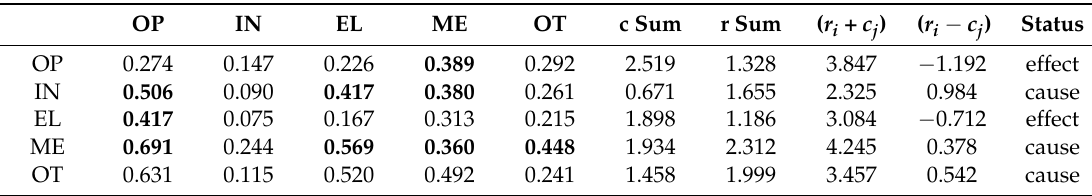
Table 5. The total relation matrix for the main clusters.